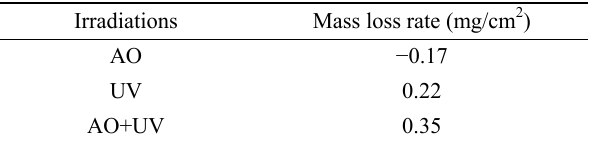
Table 3 Mass changes of the friction material under different exposure conditions.